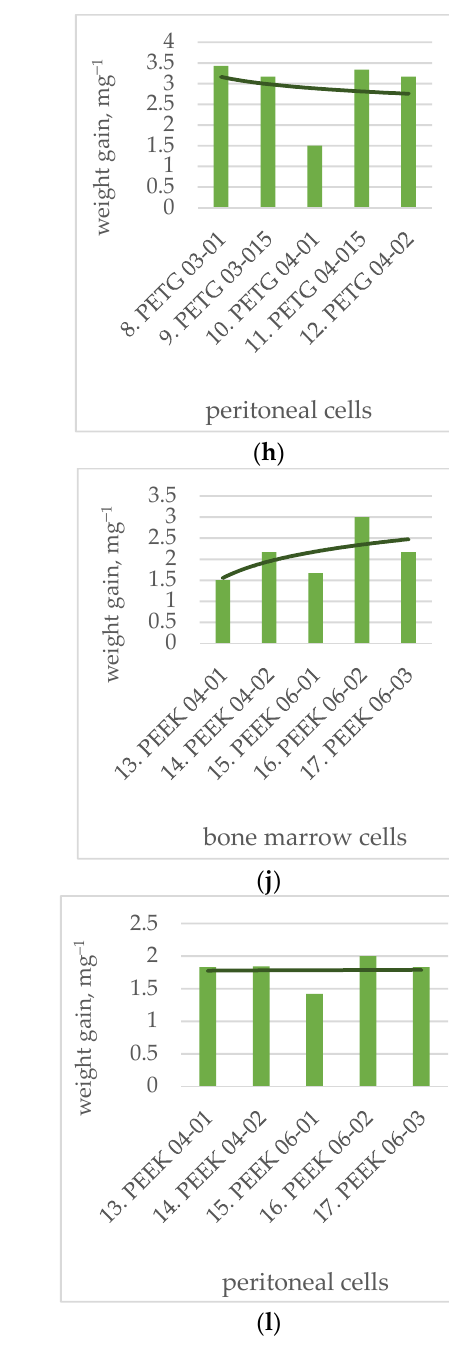
Figure 7. Trend lines of mean value for absolute number of cells per 1 μ L (medians) for polymer samples after experiments with bone marrow and peritoneal cells and trend lines of mean value of sample weight change after experiments: ( a , e , i )—absolute number of cells changing in experiments with bone marrow cells (in series PLA, PTEG, PEEK); ( c , g , k )—absolute number of cells changing in experiments with peritoneal cells (in series PLA, PTEG, PEEK); ( b , f , j )—weight gain of polymer samples in experiments with bone marrow cells (in series PLA, PTEG, PEEK); ( d , h , l )—weight gain of polymer samples in experiments peritoneal cells (in series PLA, PTEG, PEEK). A gradual decrease is observed for trend lines of the average absolute number of cells, which corresponds (in inverse proportion) to the increase in the number of adhered bone marrow cells and peritoneal cells on polymer samples in a range from (1) PLA 03- 015 to (7) PLA05-03 (Figure 7a,c) and which correlates with the gradual increase in the